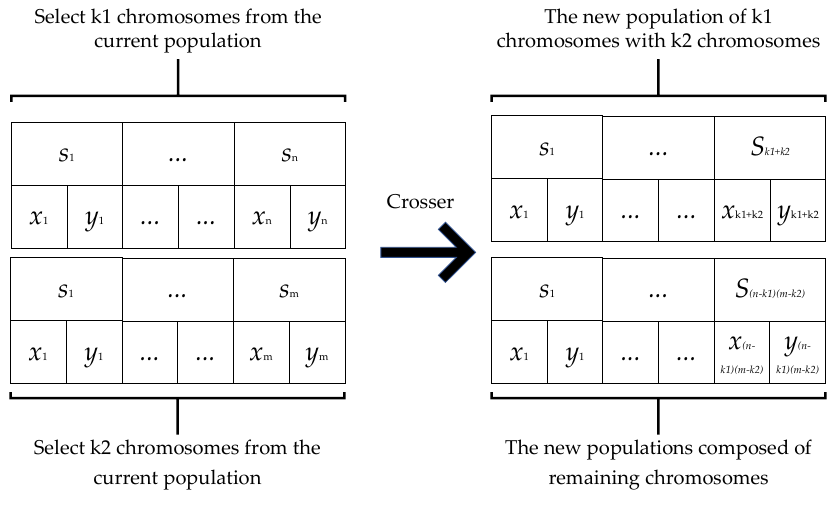
Figure 6. The process of population crossing.